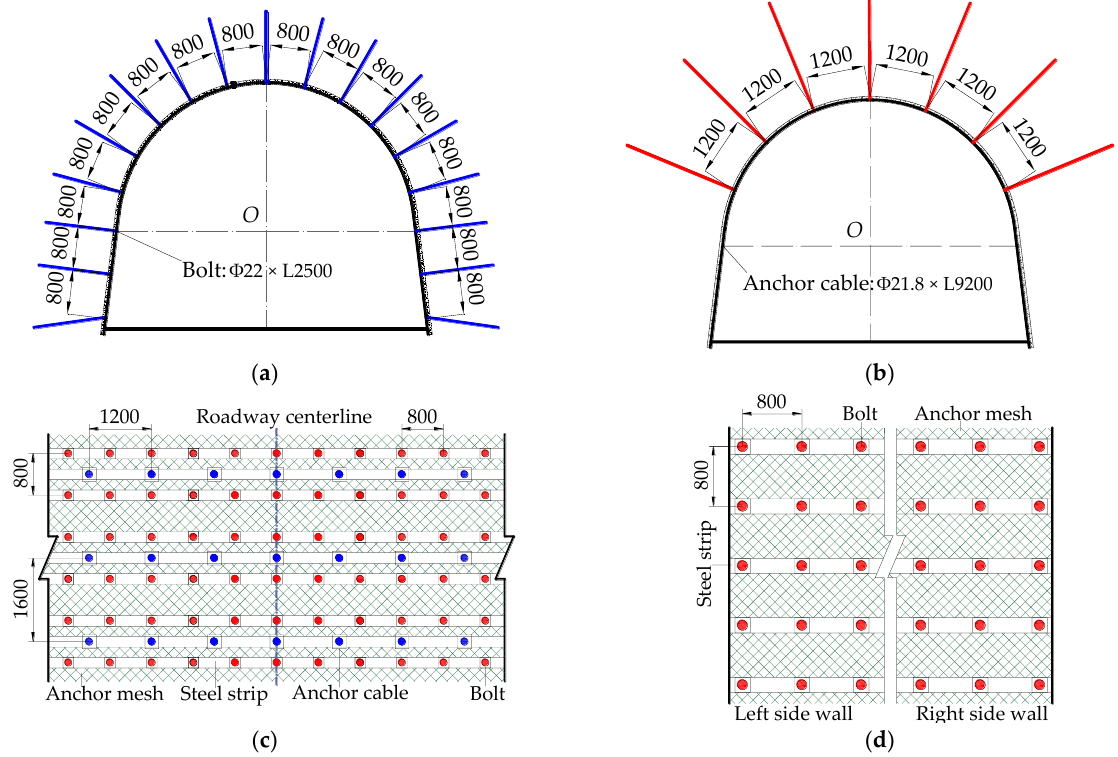
Figure 2. West-wing main track roadway original support scheme (Unit: mm): ( a ) bolt support section; ( b ) Anchor cable support section; ( c ) Roadway roof support; ( d ) Roadway wall support.